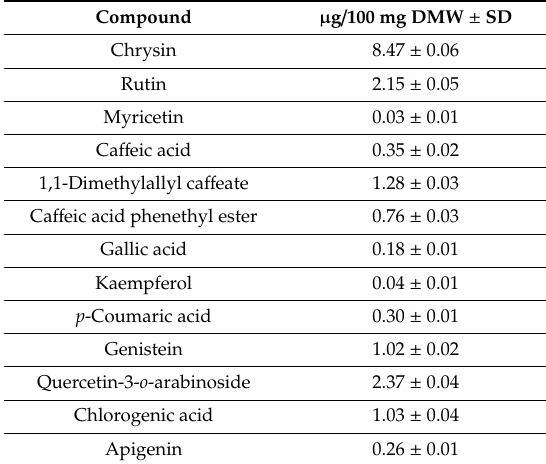
Table 1. High-performance liquid chromatography-diode array detector (HPLC-DAD) profiles of oregano extract. Plant molecules and their concentration, detected in hydroalcoholic oregano extract (HCOE) by HPLC-DAD analysis, are reported. Results were indicated as µ g of metabolite per 100 mg of dried material ( µ g / 100 mg DMW) and represent the mean ± SD of six independent experiments.